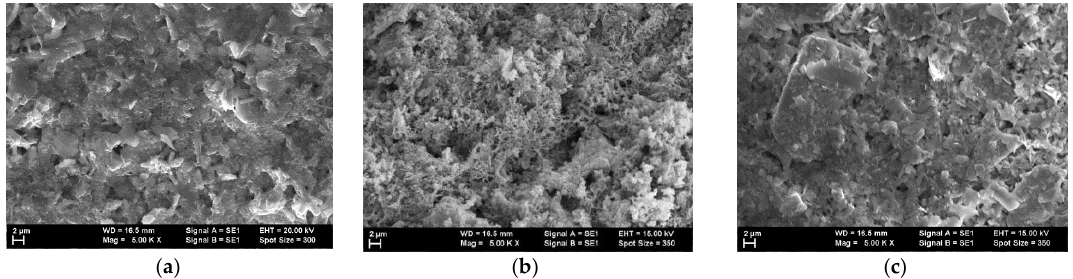
Figure 9. ( a ) Image of SnSe 2 powder. ( b ) Image of the ZnTAPP powder. ( c ) Image of the SZP Figure9. ( a )ImageofSnSe 2 powder. ( b )ImageoftheZnTAPPpowder. ( c nanocomposite.